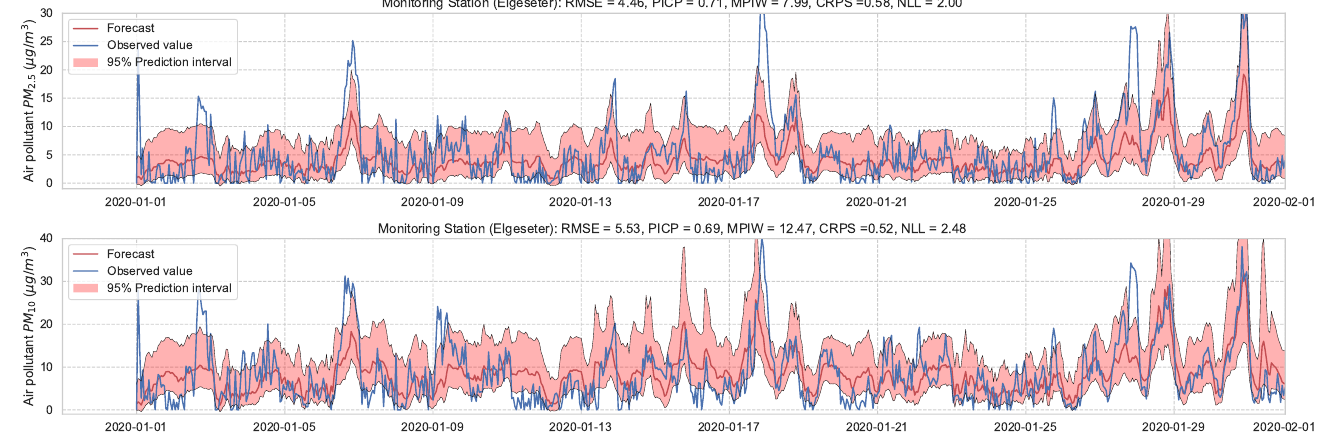
Figure 15. Probabilistic forecasting of multivariate time-series air quality using a deep ensemble.